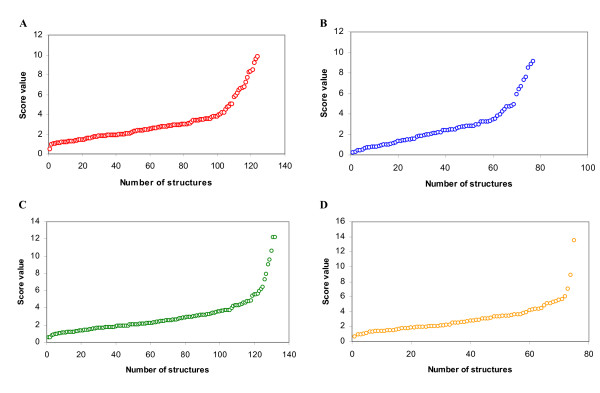
Score value calculated for all the proteins belonging to the four structural classes. (A) "mainly-alpha", (B) "mainly-beta", (C) "alpha+beta" and (D) "alpha/beta". The score values are calculated summing for all the proteins the ratios of the differences between the calculated and predicted values for each of four properties (number of MM-type H-bonds, void and water molecules, and total accessibility) versus the related RMSE.